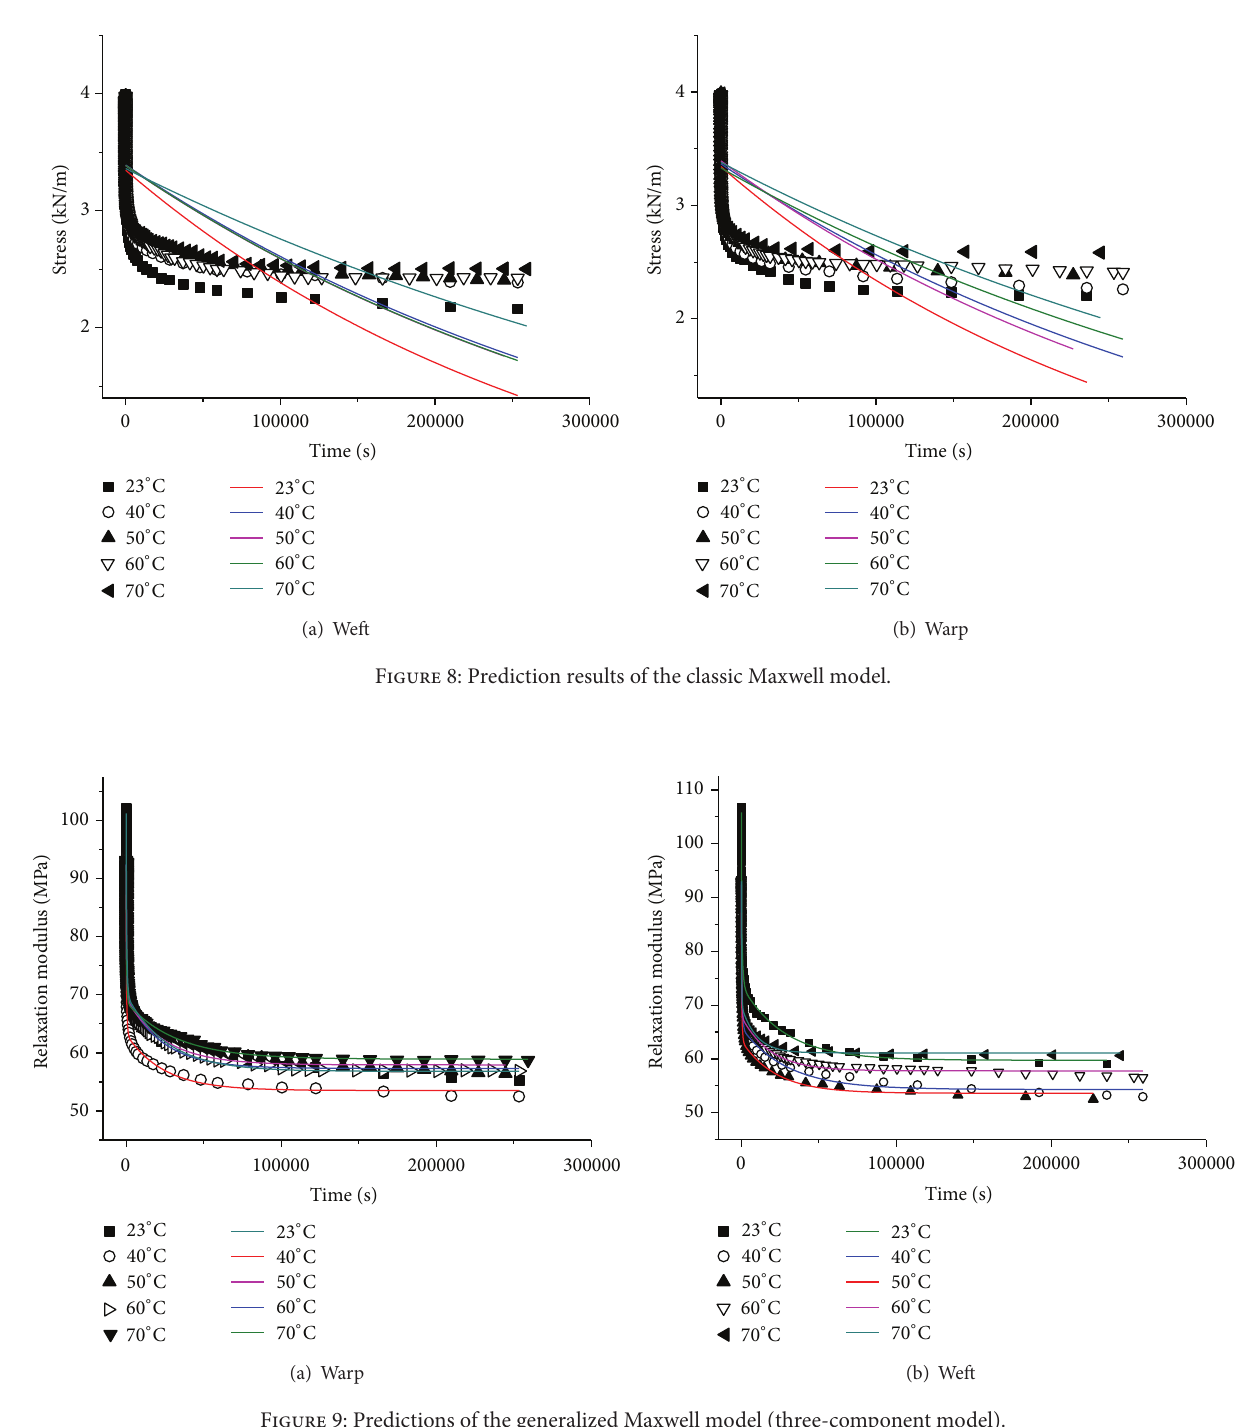
Figure 9: Predictions of the generalized Maxwell model (three-component